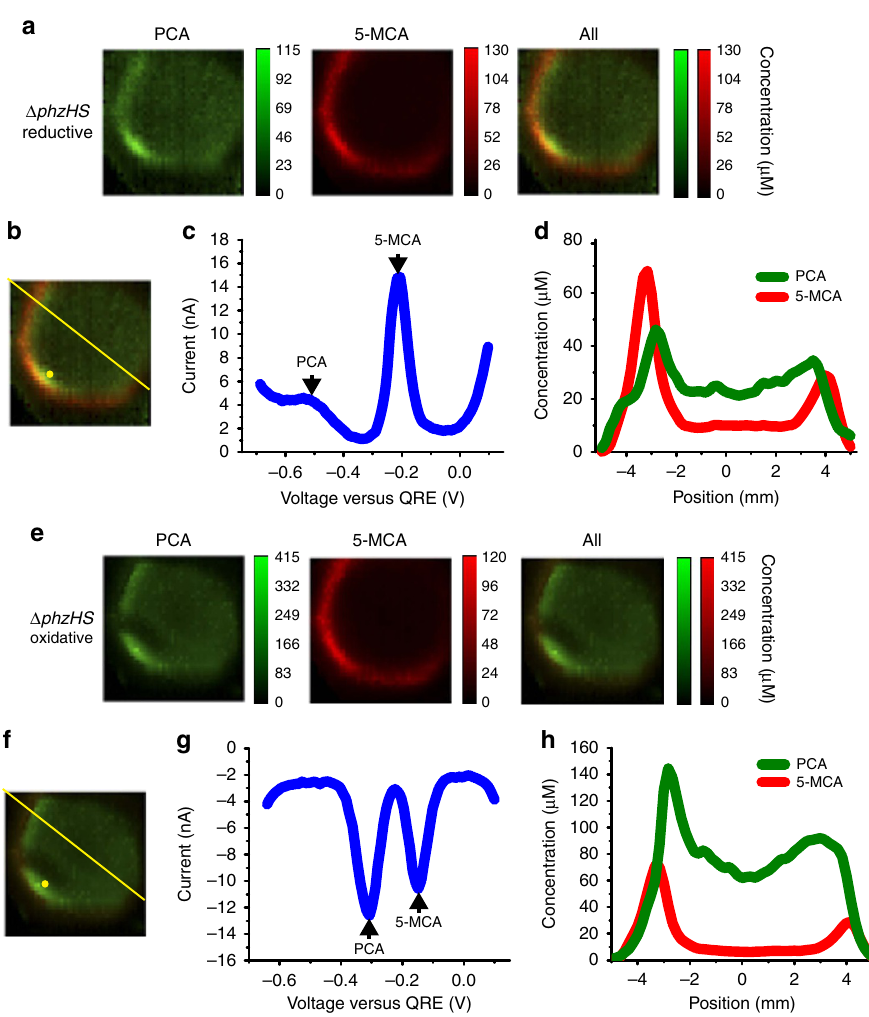
Figure 4 | Electrochemical imaging of a D phzHS biofilm. ( a ) Electrochemical imaging, based on reductive SWV, of a D phzHS biofilm after 2 days of development Pixel intensity is proportional to phenazine concentration. PCA, green; 5-MCA, red. Maximum error due to electrode variability is 14 m M for PCA and 15 m M for 5-MCA. Images are 8mm (cid:2) 8mm. ( b ) Locations of example square-wave voltammogram and cross-section in c , d , respectively. ( c ) Example square-wave voltammogram from a single electrode. ( d ) Example cross-section from the electrochemical image in a . ( e ) Electrochemical imaging, based on oxidative SWV, of the same D phzHS biofilm shown in a . Pixel intensity is proportional to phenazine concentration. PCA is shown in green and 5-MCA in red. Maximum error due to electrode variability is 74 m M for PCA and 12 m M for 5-MCA. Images are 8mm (cid:2) 8mm. ( f ) Locations of example square-wave voltammogram and cross-section in g , h , respectively. ( g ) Example square-wave voltammogram from a single electrode. ( h ) Example cross-section from the electrochemical image in e